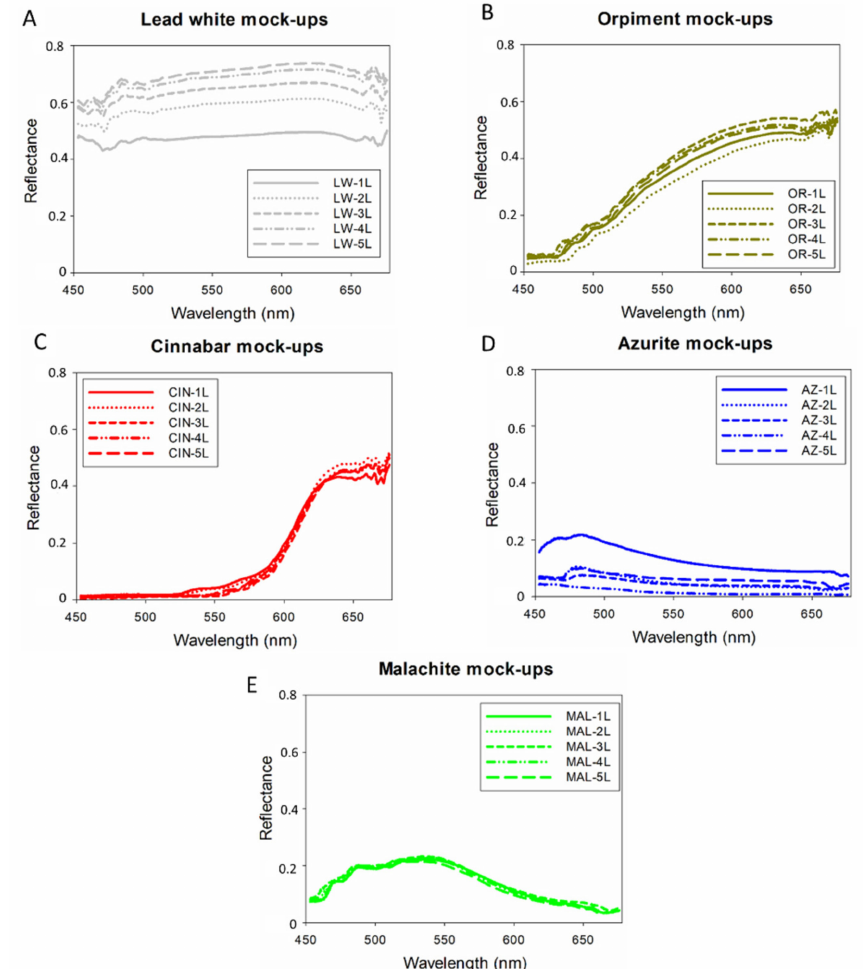
Figure 2. Reflectance spectra of the painting mock-ups used to determine the influence of the thickness of the paint layers (one to five layers, 1L to 5L) on the reflectance. ( A ) Lead white (LW)-based oil painting mock-ups. ( B ) Orpiment (OR)-based oil painting mock-ups. ( C ) Cinnabar (CIN)-based oil painting mock-ups. ( D ) Azurite (AZ)-based oil painting mock-ups. ( E ) Malachite (MAL)-based oil painting